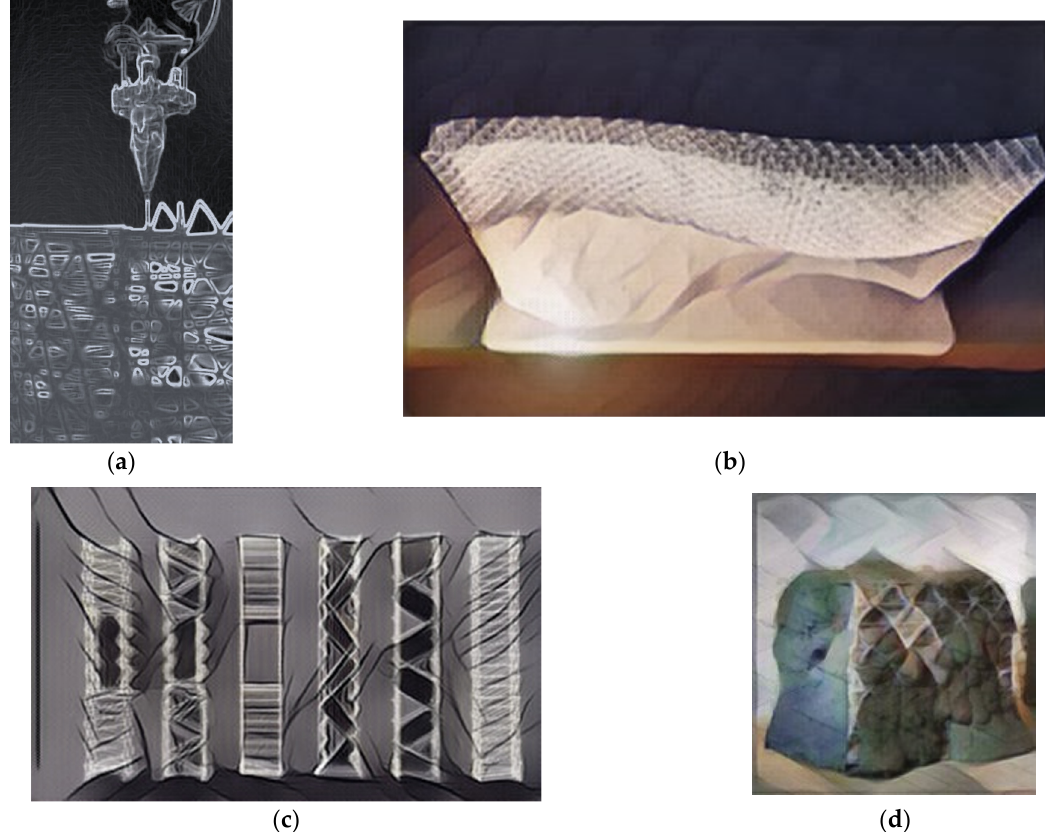
Figure 4. Mesh molds ( a ) polymer extrusion; ( b ) first mesh prototype filled with concrete; ( c ) various mesh models; ( d ) test cubes after casting. Images created by A. Skoratko (inspired by [51,52).